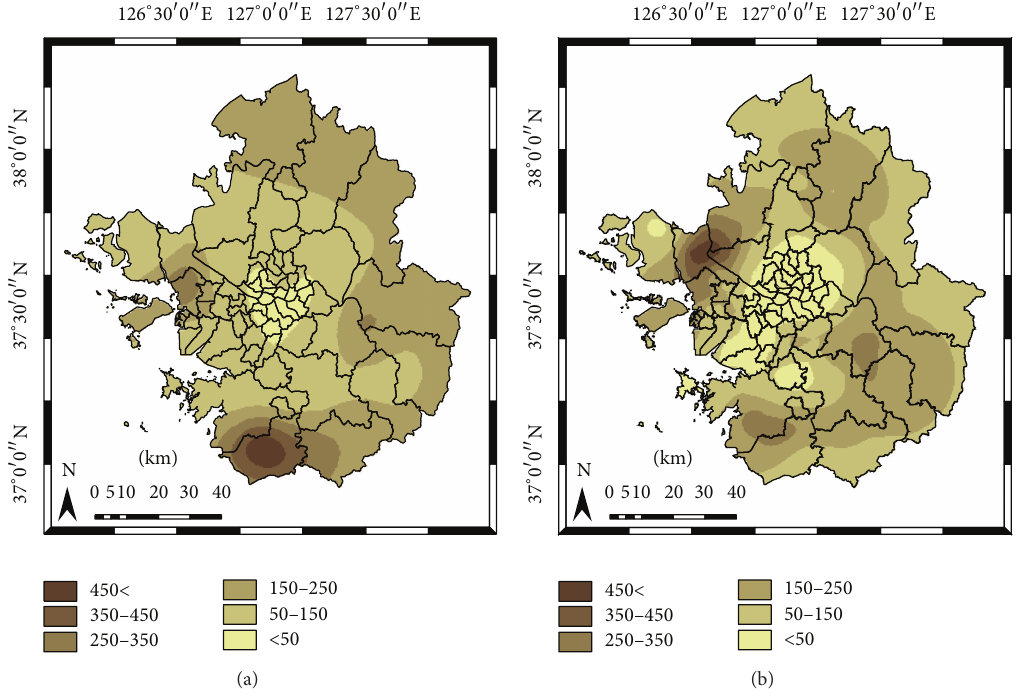
Figure 7: Conditional variance for (a) April 2009 and (b) August 2009.